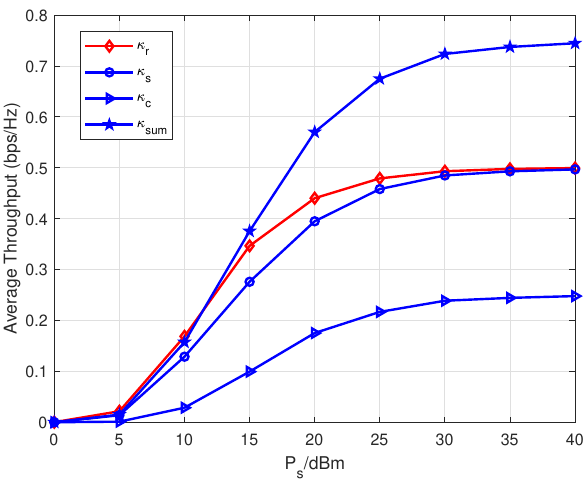
Figure 7. Average throughput versus P s